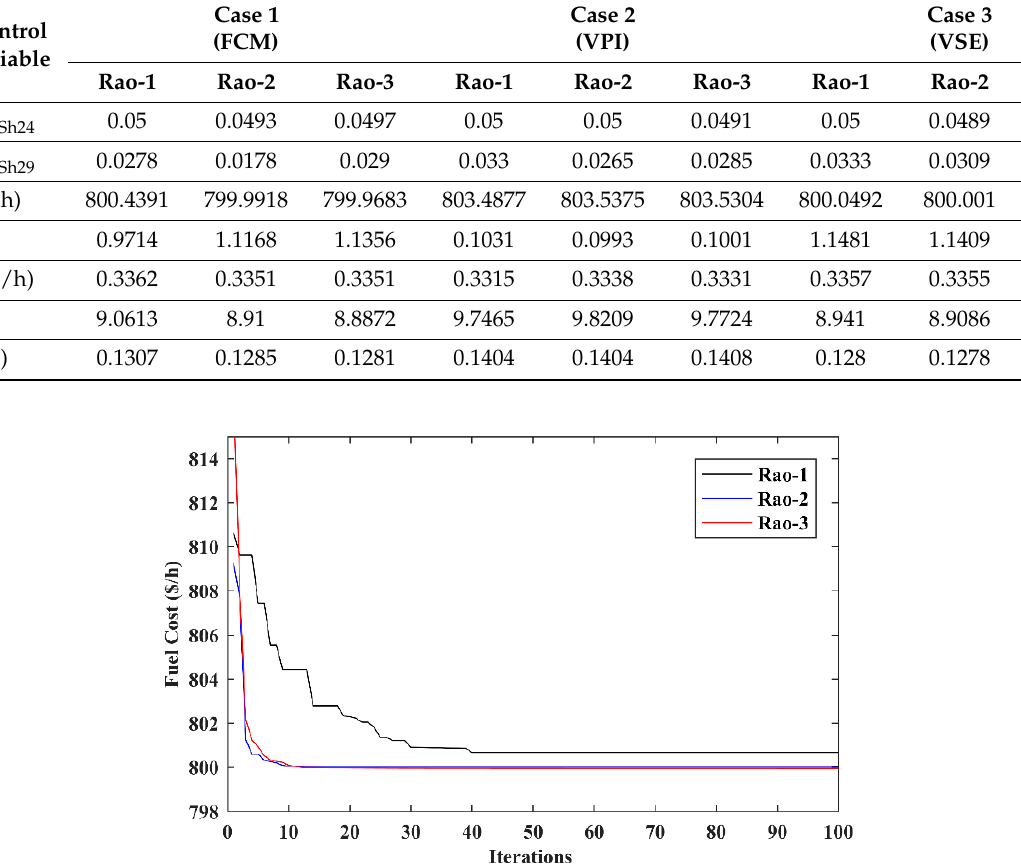
Figure 2. Convergence characteristics for the IEEE 30-bus system, Case 1. Table 2. C ase 1: FCM in the IEEE 30-bus system.